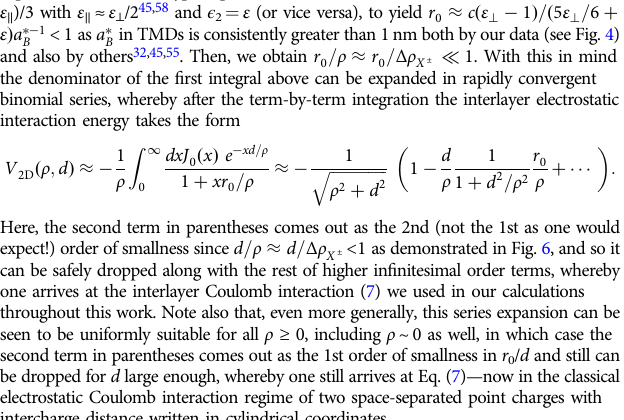
ffiffiffiffiffiffiffiffiffiffiffiffiffiffiffiffiffiffiffiffiffiffiffiffiffiffiffiffiffiffiffiffiffi ð R (cid:2) r = 2 Þ 2 þ d 2 2